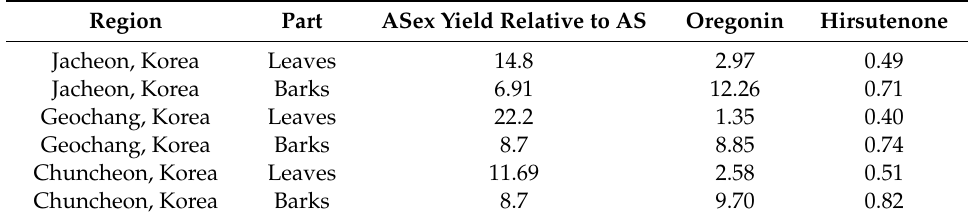
Figure 2. Linearity and correlation coefficients of effective (indicator) components (R 2 ). ( a ) Oregonin; ( b ) hirsutenone. Table 1. ASex yield (%) and indicator content (%) from each region determined by high-performance liquid chromatography (HPLC).